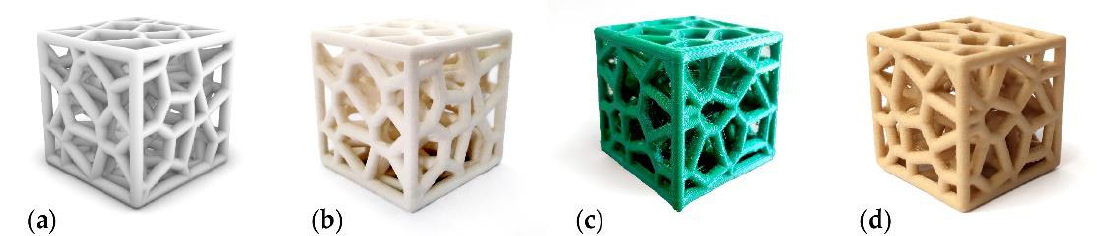
Figure 10. Comparison between: ( a ) the digital model of the biomimetic Voronoi lattice; ( b ) the 3D- printed sample using PLA filament; ( c ) the printed sample with the PLA/PHA compound filament; ( d ) the printed sample with the PLA/PHA/wood fiber composite filament.